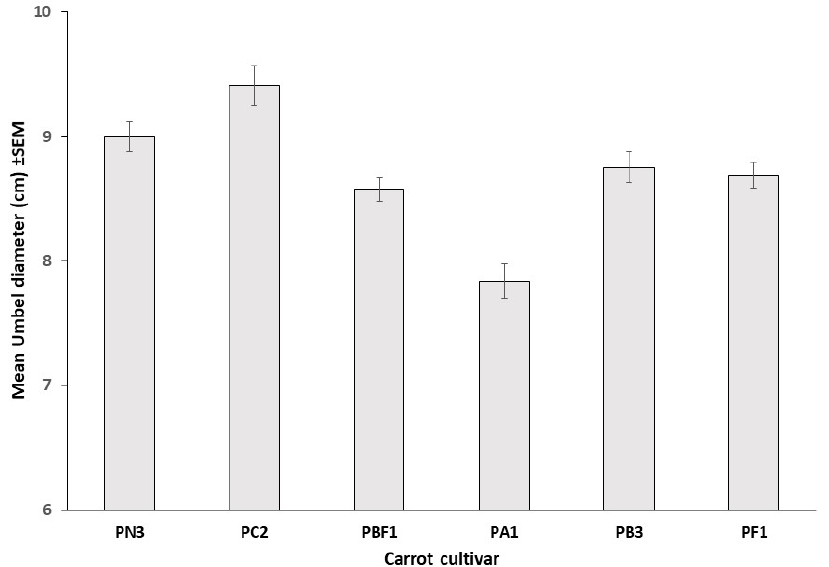
Figure 2. Mean ( ± SEM) umbel diameters of six hybrid CMS carrot cultivars assessed in field trial B (n = 210, 208, 160, 202, 204, 214).